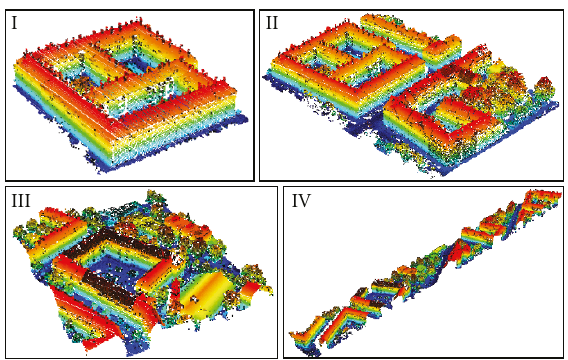
Figure 6: The four manually chosen landmarks (I–IV). Each landmark is of di ff erent size and structure.